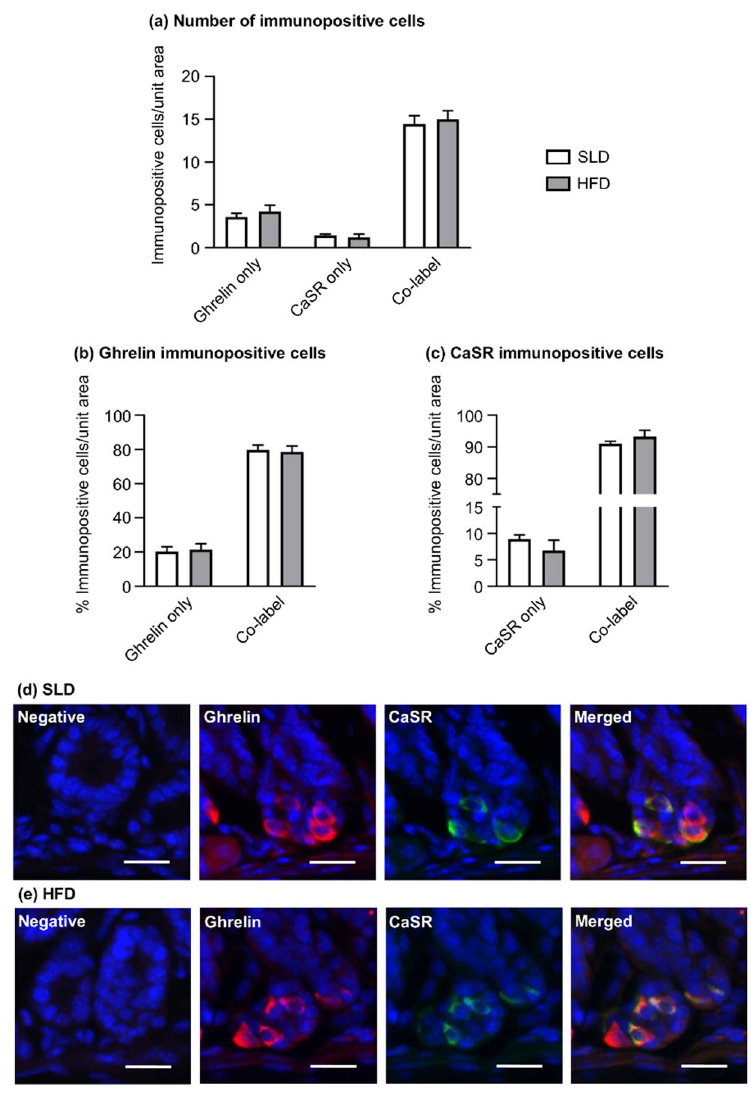
Figure 4. Co-expression of ghrelin and CaSR in the antrum of mice fed standard laboratory diet (SLD, n = 5) and high-fat diet (HFD, n = 5) for 12 weeks. ( a ) Most immunopositive cells co-expressed ghrelin and CaSR. ( b ) Approximately 80% of ghrelin immunopositive cells expressed CaSR in SLD and HFD-fed mice, ( c ) and over 90% of CaSR immunopositive cells contained ghrelin, independently of the diet. ( d , e ) Images of ghrelin and CaSR co-expression in the gastric antrum of SLD and HFD mice. Cell counts are the mean counts of 5–6 tissue sections per mouse and gastric region (unit area = 159 × 159 µ m). Data are expressed as mean ± SEM. Statistical significance was determined by two-way ANOVA followed by Sidak post hoc test.